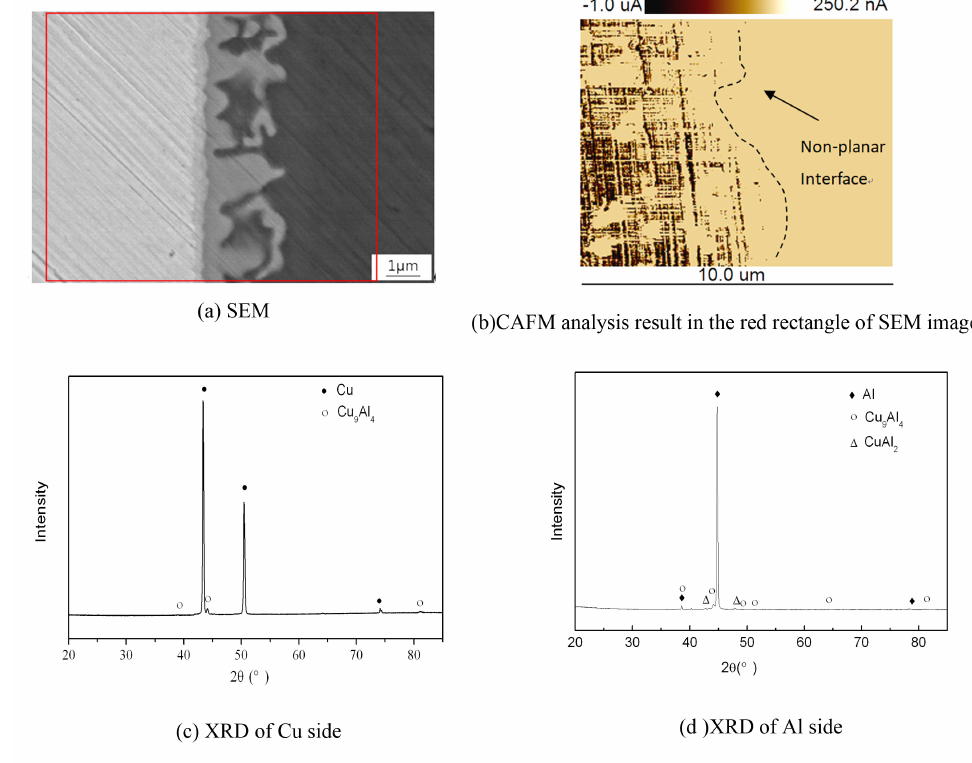
Figure 7. SEM,CAFM and XRD results of flash welded Cu/Al joint: (a) SEM; (b) CAFM analysis result in the red rectangle of SEM image; (c) XRD of Cu side; (d) XRD of Al